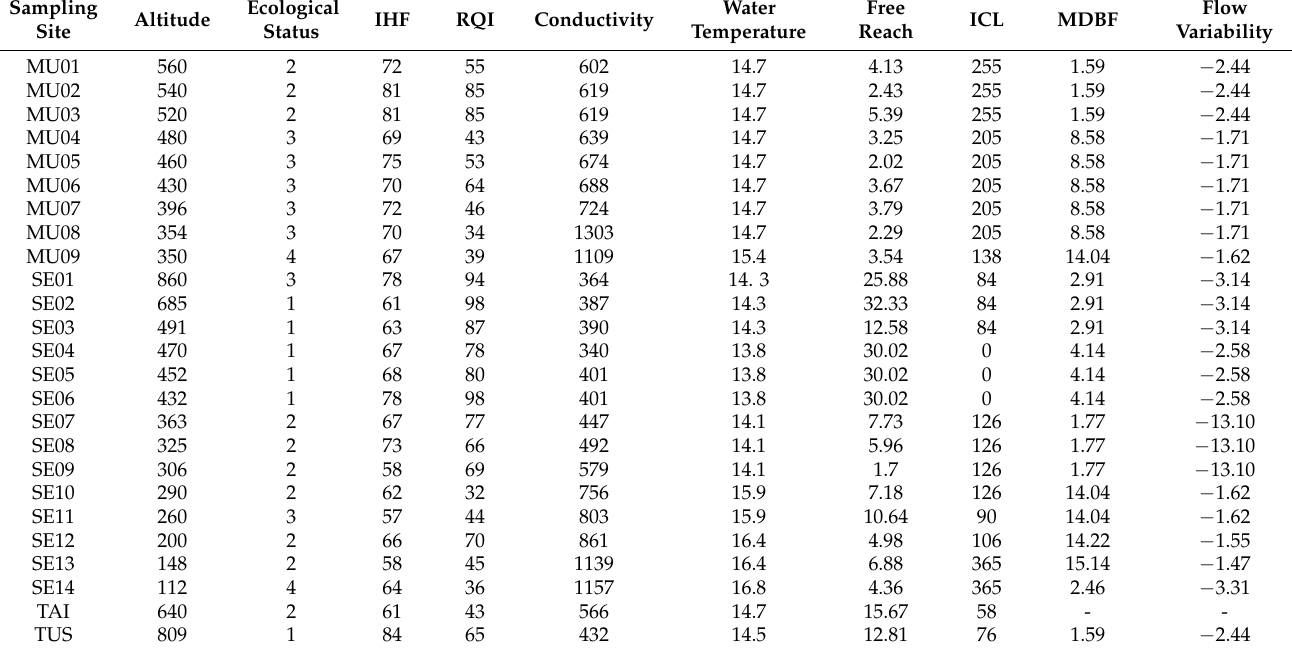
Table 1. Environmental variables and gradient descriptors measured or calculated at sampling sites. Altitude (meters above sea level), ecological status (categorized as: 1 = high; 2 = good; 3 = moderate; 4 = poor), Fluvial Habitat Index (IHF) and Riparian Quality Index (RQI) (%), conductivity ( µ S cm − 1 ), free reach (km), Longitudinal Connectivity Index (ICL), water